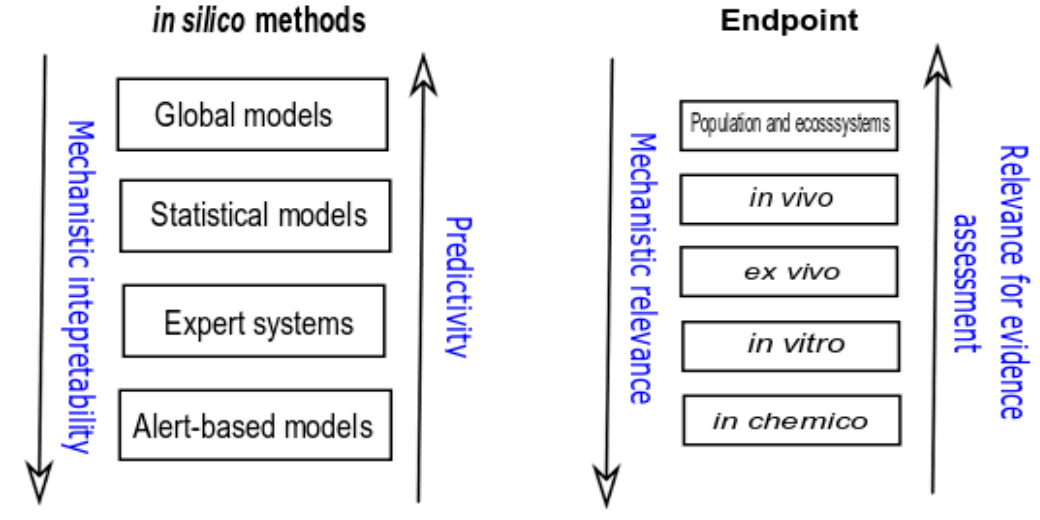
Figure 3. Mechanistic interpretability, predictivity, and transparency levels generally assumed for different in silico models and toxicological endpoints.